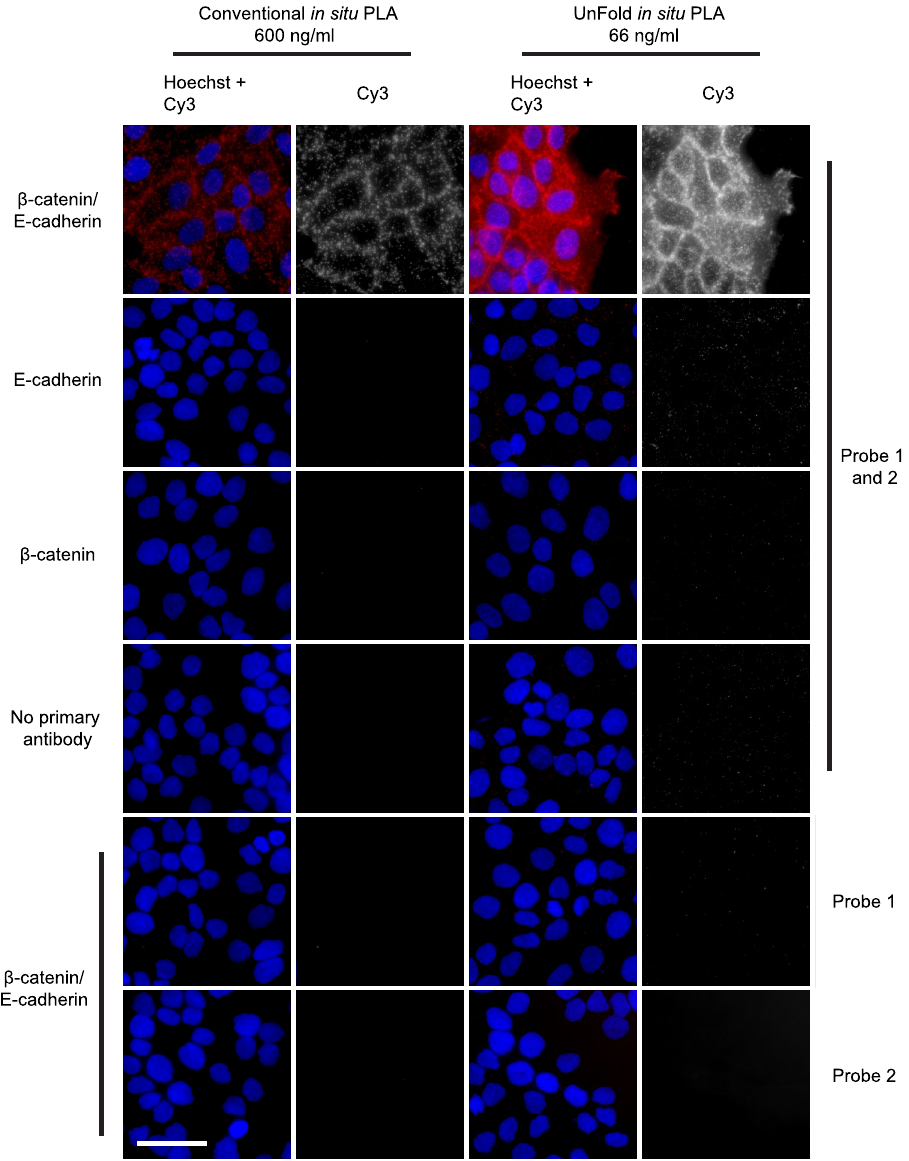
Figure 3. Image panel of HaCat cells showing detection of β -catenin/ E-cadherin interactions along with several technical controls. In the top row images, both of the primary antibodies and the PLA probes were included, revealing the characteristic β -catenin/ E-cadherin interaction stain. For the remaining rows in the panel, one or more of the primary or secondary antibodies were excluded. All signals were stained with Cy3 (Red in merge images and in grayscale) and the nuclei were stained with Hoechst 33342 (Blue). Scale bar (white) = 50 μ